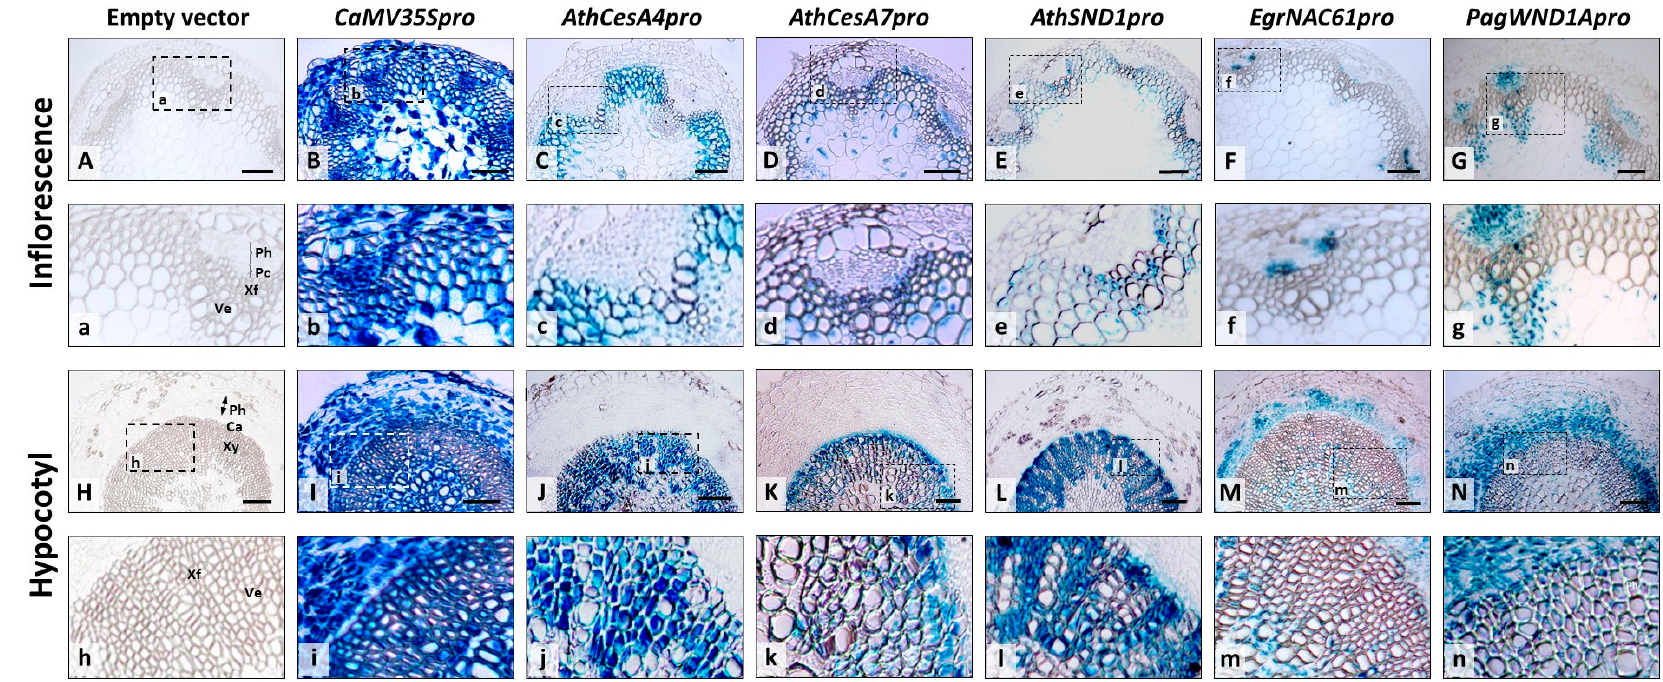
Figure 2. Tissue-specific expression analysis of SND1 orthologous promoters in Arabidopsis inflorescence and hypocotyl stems. Representative GUS reporter analyses of six week-old Arabidopsis plants are shown. Panels A – G indicate inflorescence stem cross sections, where panels a – g represent magnified portions of the regions indicated by dashed-line boxes in panels A – G , respectively. Panels H – N indicate hypocotyl stem cross sections, with panels h – n representing magnified version of the dashed-line boxes in panels H–N , respectively. Ca, cambium; Pc, procambium; Ph, phloem; Ve, vessel; Xf, xylary fibre; Xy, xylem. Scale bar = 100 µm.